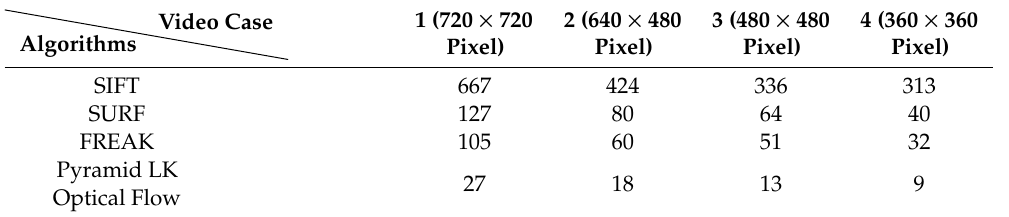
Table 1. The average time-consuming of each feature matching algorithm (ms). Video Algorithms